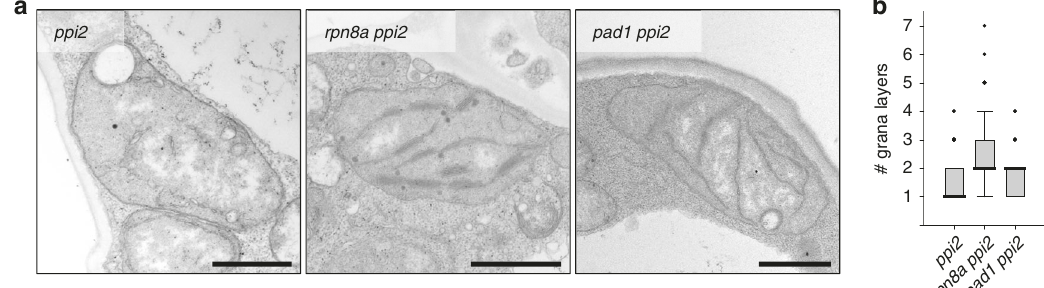
Fig. 2 Characterization of plastid ultrastructure by transmission electron microscopy (TEM). a TEM pictures of representative plastids from ppi2 , rpn8a ppi2 , and pad1 ppi2 mutant plants. Scale-bar represents 1 µ m. b Box-plot representation of the number of stacks counted from three thylakoid stacks per plastid for the three tested genotypes ( n = 153 plastids, 459 thylakoid stacks). Note the median values for the number of stacks, i.e., ppi2 = 1, rpn8a ppi2 = 2, and pad1 ppi2 = 2